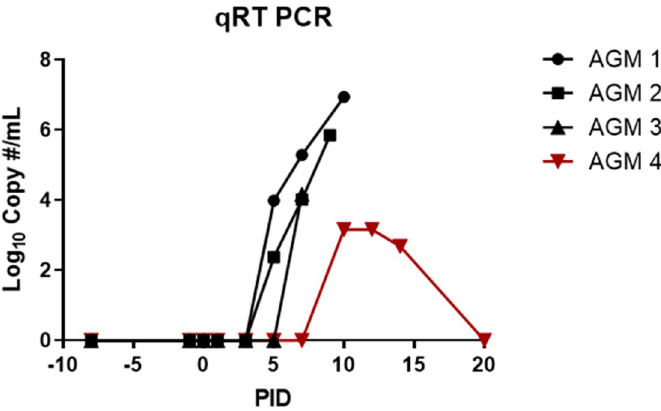
Fig 8. PBMC-associated viral RNA as detected by qRT-PCR. RT-PCR was performed on PBMCs for all animals on study. Shown is the Log 10 copy #/mL for each animal. Black symbols are APN and the red symbols are the CPN.